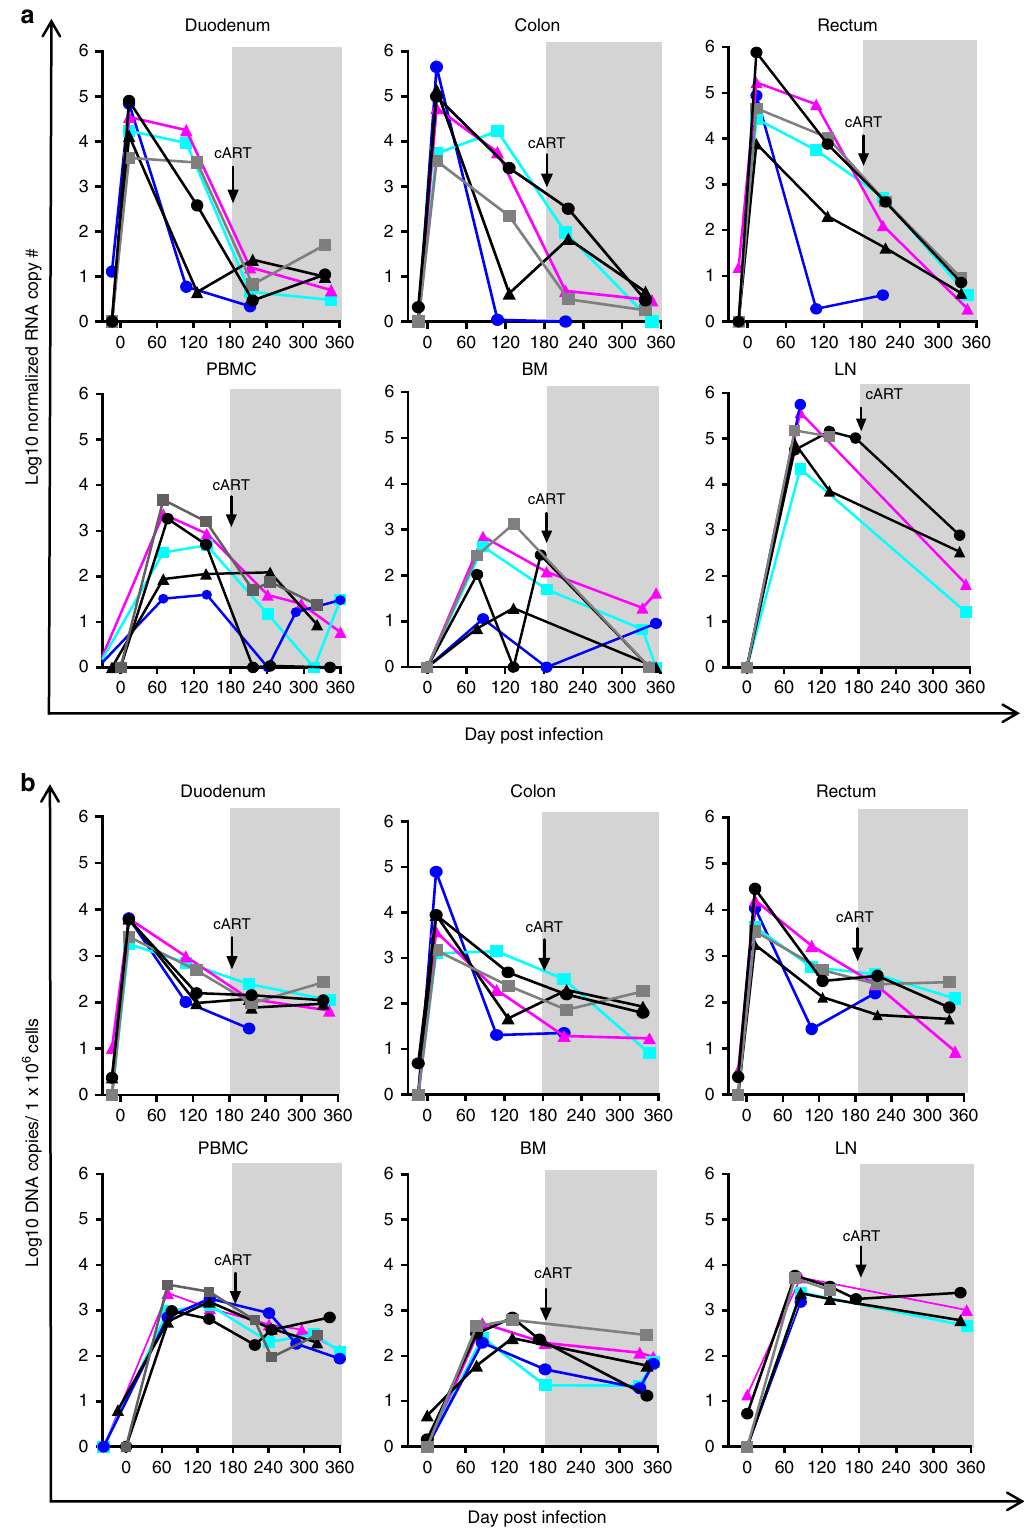
Fig. 2 Longitudinal reservoir analysis in SHIV-C infected macaques before allogeneic bone marrow transplantation. a Six tissues (PBMC, BM, pooled inguinal and axillary LN, duodenum, colon, rectum,) were collected longitudinally at the indicated time points post-infection and cART. Total RNA was extracted from each tissue and subjected to qPCR for viral RNA with GAG speci fi c primers. SHIV genomic RNA was normalized to the crossing threshold value of the genomic standard MRPP30. b Total genomic DNA (gDNA) was extracted from the same tissues as in a , total SHIV DNA was measured by qPCR, and was normalized to 1 × 10 6 cell equivalents with the aid of a genomic DNA standard (macaque RNaseP p30, MRPP30)